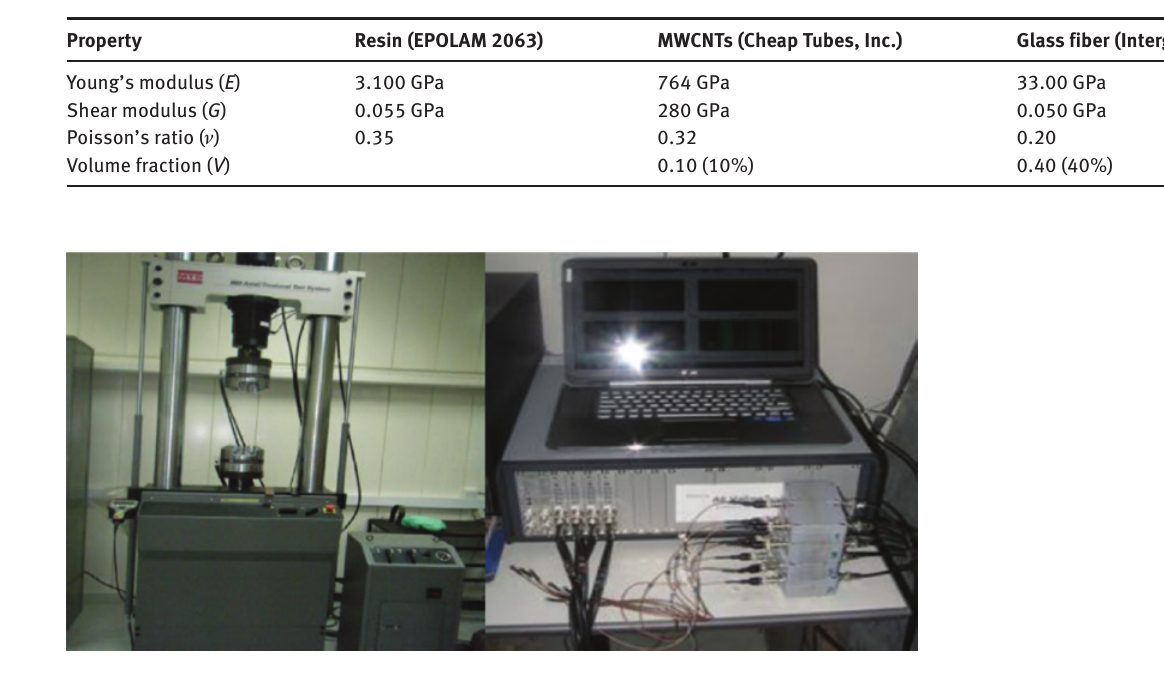
Figure 1: Experimental equipment configuration.